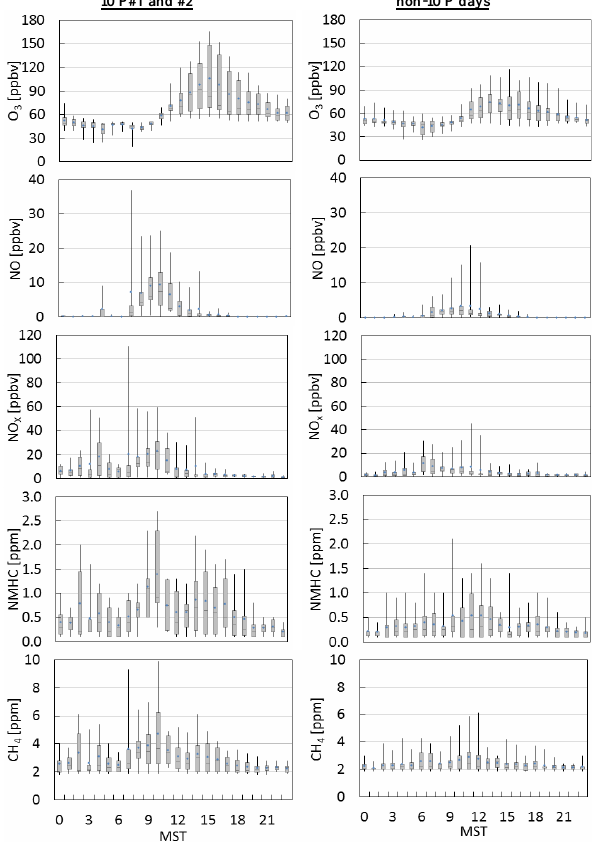
Figure 3a. Mean diurnal variation of selected trace gases for IOP and non-IOP